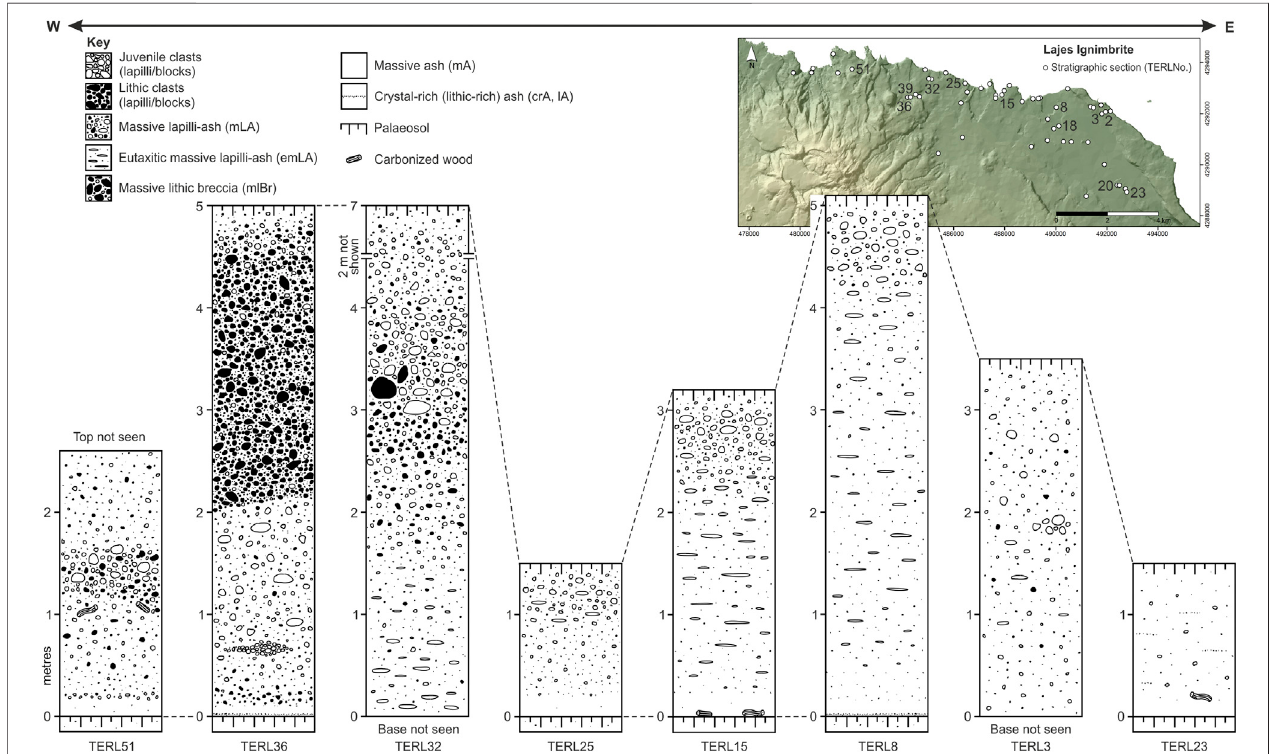
FIGURE 8 | Representative stratigraphic sections of Lajes Ignimbrite along the north coast of Terceira.